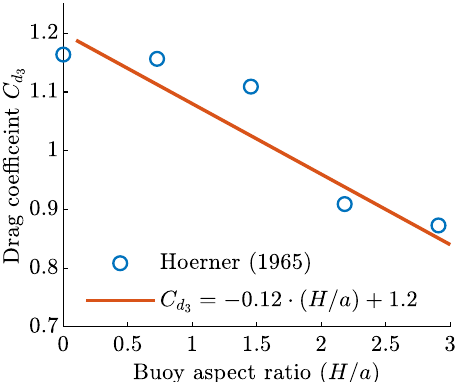
Figure 4. Drag coefficient of the cylindrical body in axial flow as a function of its aspect ratio H / a